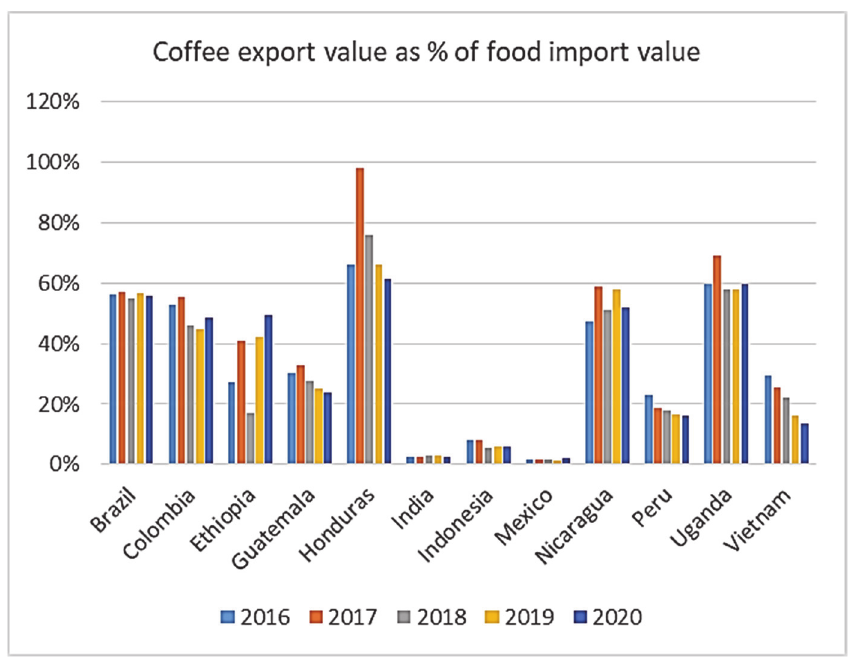
Figure 1. Coffee export revenues as % of food import expenditure, 2016–2020. Source: authors’ elaboration based on data from [24].